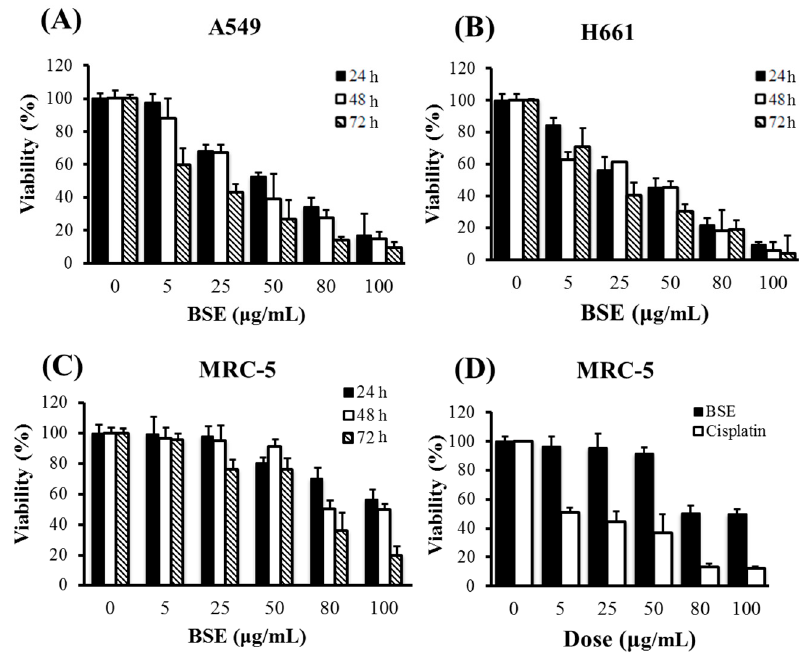
Figure 1. Effects of treatment concentration and duration of BSE on the proliferation of ( A ) lung cancer A549 cells, ( B ) H661 cells, ( C ) lung fibroblast MRC-5 normal cells, ( D ) the comparison of the effects of BSE and cisplatin on MRC-5 cells under 48 h treatment.